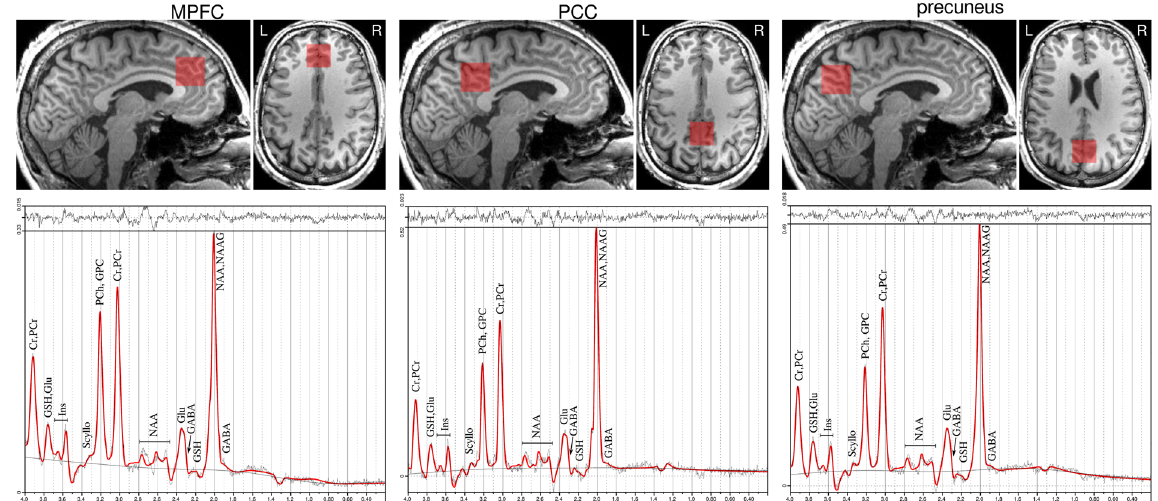
Figure 2. MRS spectra of DMN regions. Positioning of voxels in DMN regions (upper row) and respective MRS spectra (lower